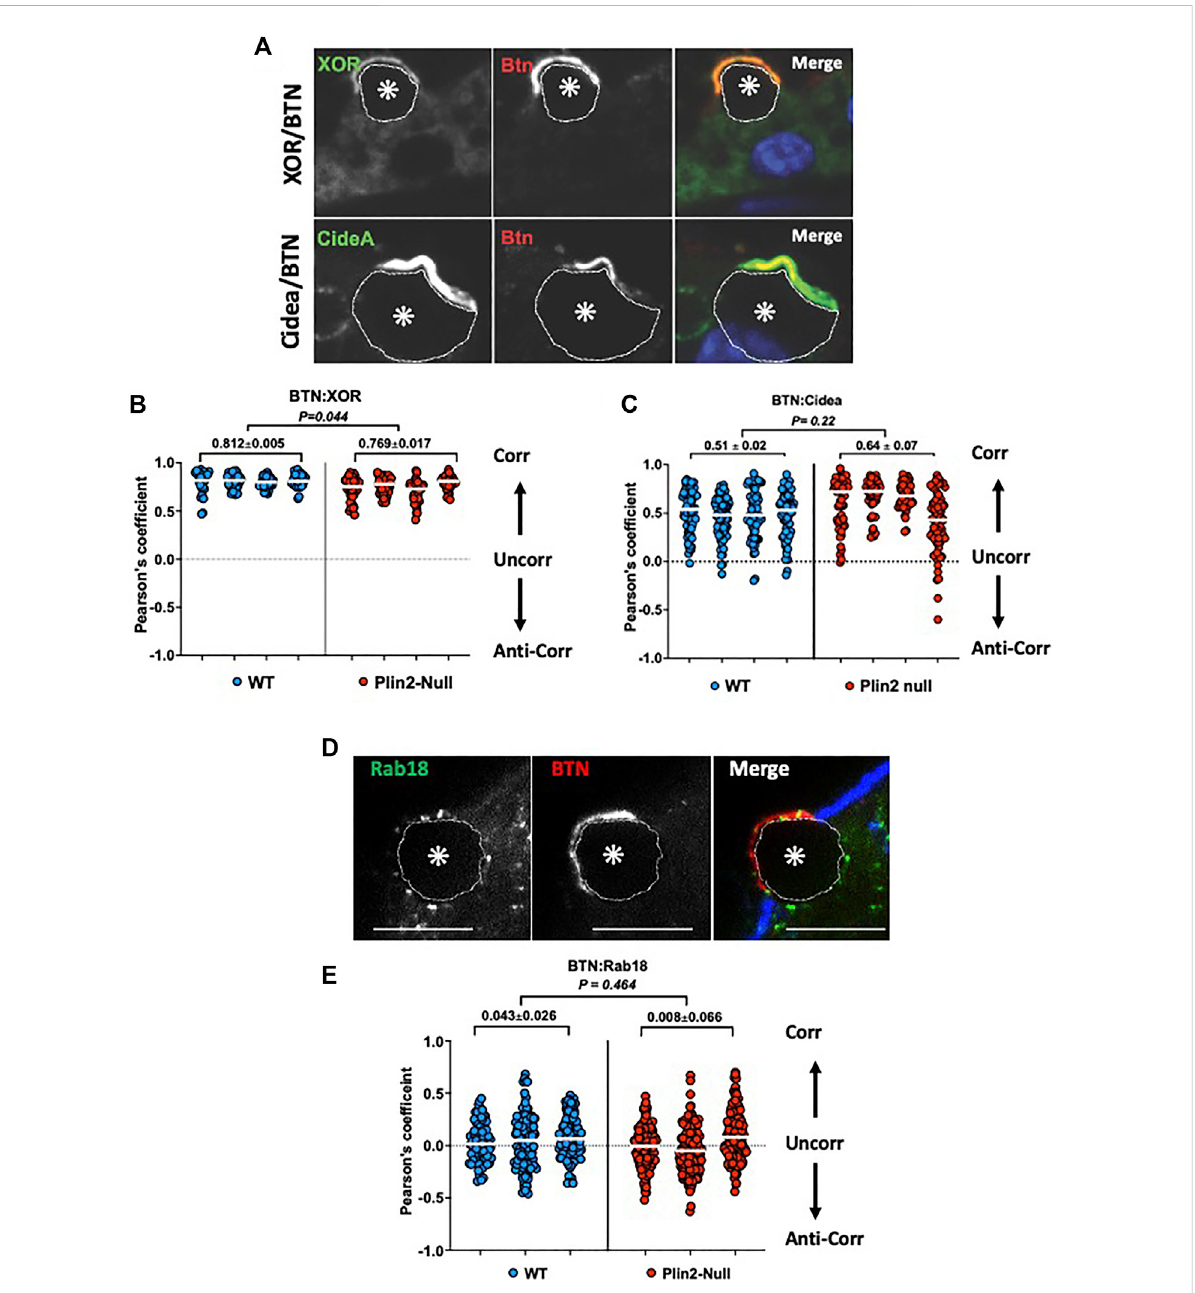
FIGURE 4 MolecularinteractionsatLD-APMcontacts.RepresentativeimagesofXOR(green/monochrome)orCidea(green/monochrome)andBTN(red/ monochrome)immuno fl uorescence (A) orRab18(green/monochrome)andBTN(red/monochrome)immuno fl uorescence (D) atLD-APMcontacts in WT mammary glands following litter removal for 2 h at L10 to inhibit milk secretion. LD in images are indicated by asterisks and outlined by dotted white lines. Blue fl uorescence in D is Alexa633-tagged wheatgerm agglutinin staining of the APM glycocalyx. Bar is 10 µ. (B , C , E) Pearson ’ s correlation coef fi cients describing immuno fl uorescence overlap between BTN and XOR (B) , BTN and Cidea (C) , or BTN and Rab18 (E) in 40 – 60 sMEC/animalfrom3 – 4WTandPlin2-Nulldamsfollowinglitterremovalfor2 hatL10.Medianvaluesareindicatedbywhitebarsandaverage medians ±SEM are shown above each group. p -values for group differences were determined by nested t -test and are shown at the top of each fi gure. Pearson ’ s coef fi cients of 1, 0 and − 1 respectively represent perfect positive correlation (Corr), no correlation (Uncorr.) and perfect negative correlation (Anti-corr.).